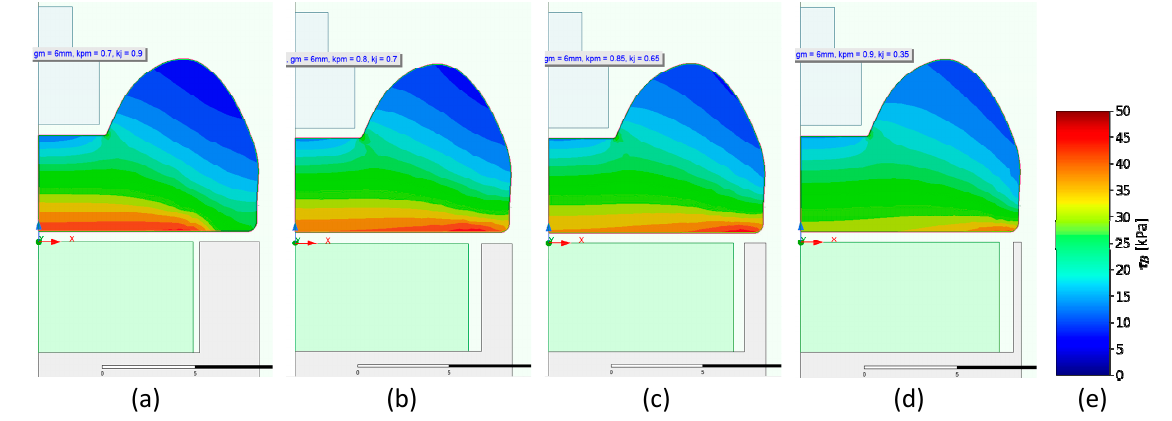
Figure 16. Shear stress distribution in the cushion cross section at gm = 6 mm for configurations: ( a ) kpm = 0.7 and kj = 0.35; ( b ) kpm = 0.8 and kj = 0.7; ( c ) kpm = 0.85 and kj = 0.65; ( d ) kpm = 0.9 and kj = 0.35; ( e ) color scale indicating shear stress value.